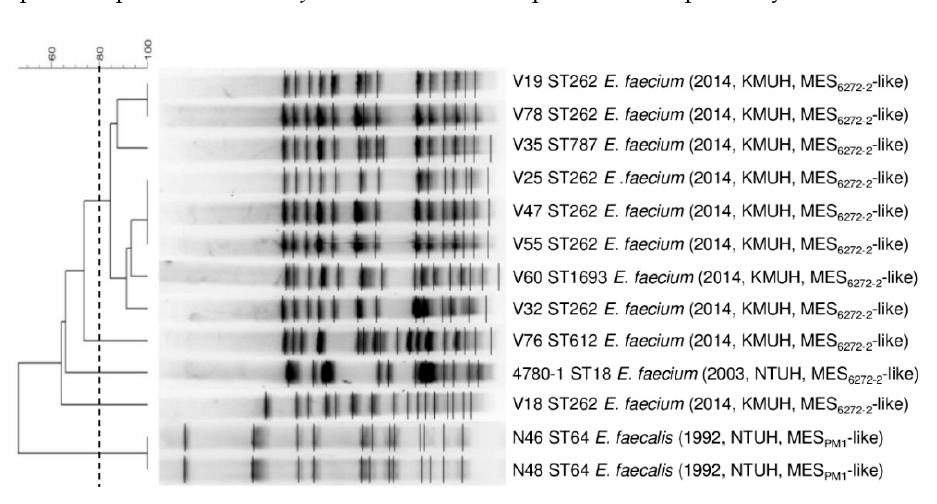
Figure 1. PFGE analysis of the 13 MES-carrying enterococcal strains. The dendrogram was produced by BioNumerics software, showing distance calculated by the Dice similarity index of SmaI-digested DNA fragments. The degree of similarity is shown in the scale. The strain number, ST, species, isolation year, isolation hospital, and MES types are indicated in the figure.